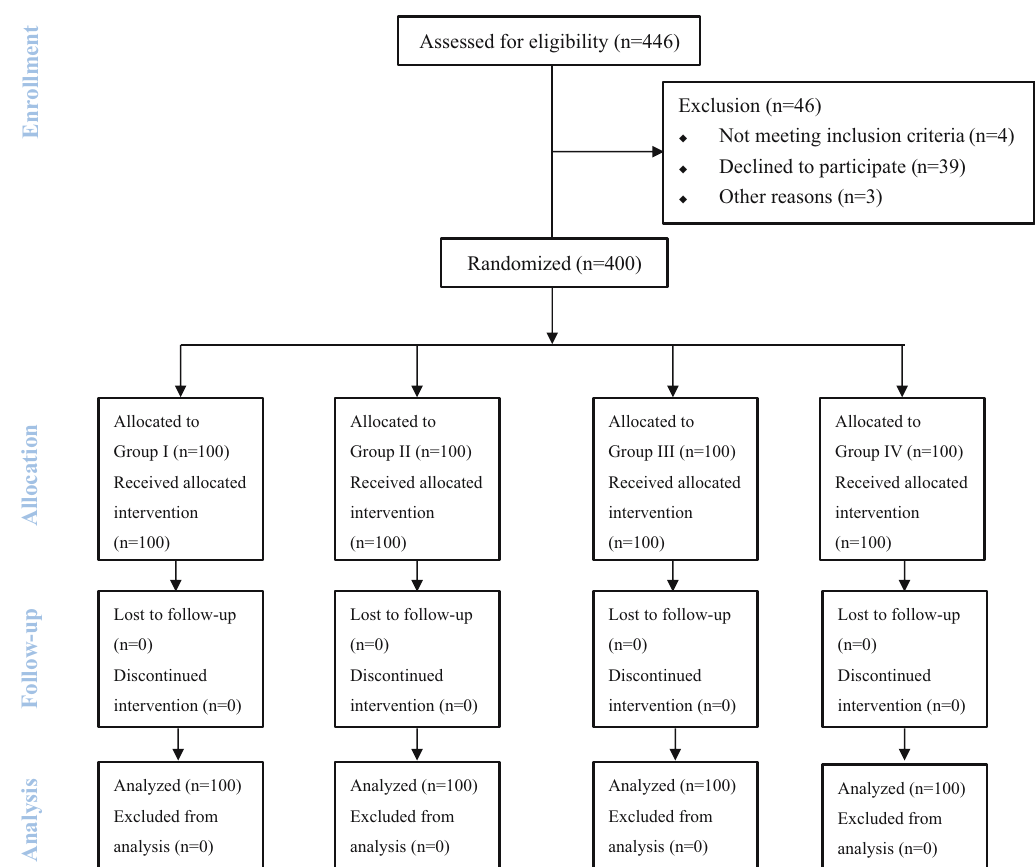
Figure 1: Enrollment and randomization of the